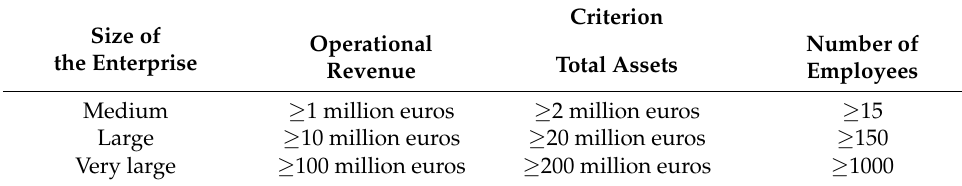
Table 1. The categorization according to the ORBIS database. Source: own processing.